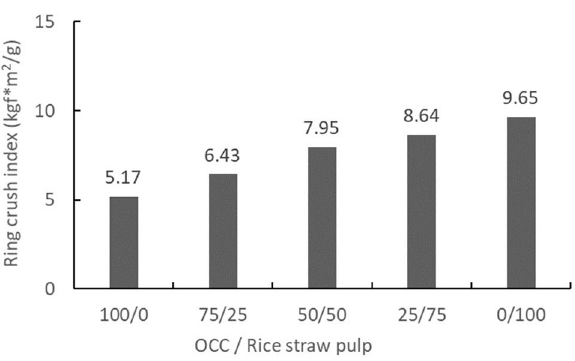
Figure 11. The effect of blending ratios of rice straw semi-chemical mechanical pulp with OCC on the burst indices of the handsheets (expanded